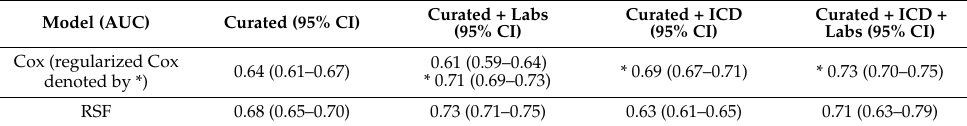
Table 2. Cox and RSF model performance with different predictor datasets.